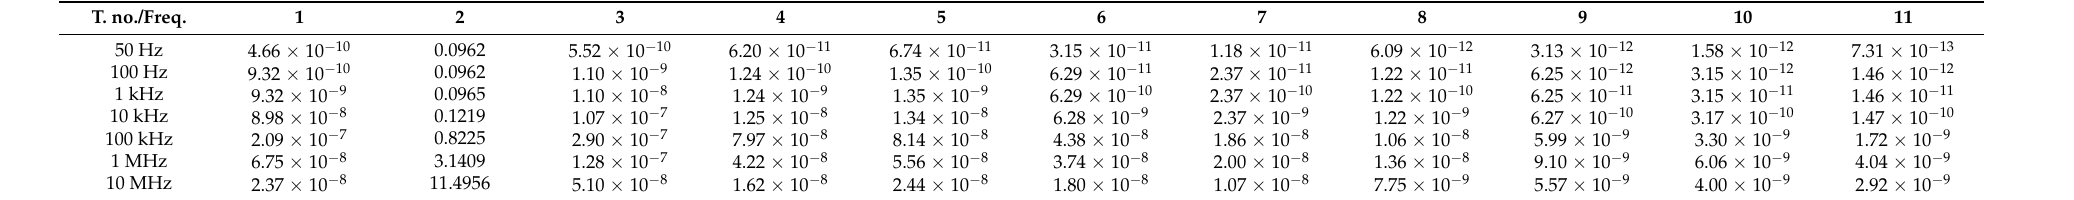
Table A11. Self and mutual resistances of turn 2 (in Ω ) resulting from FEM simulations. T. no./Freq.